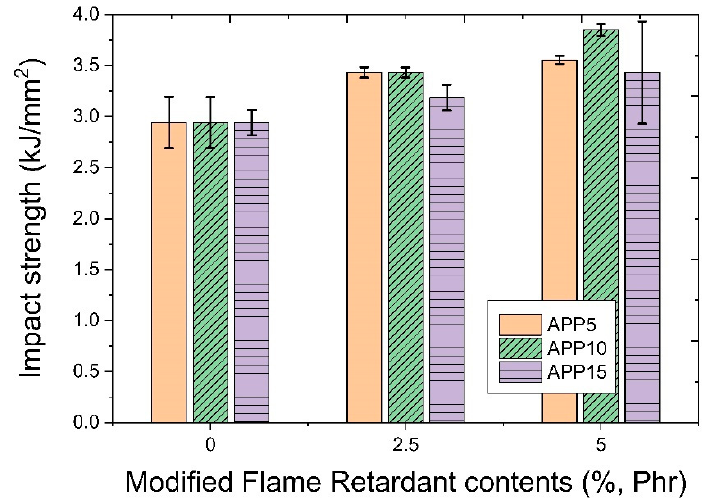
Figure 13. Impact strength characteristics as a function of the amount of modified flame retardant and APP added.